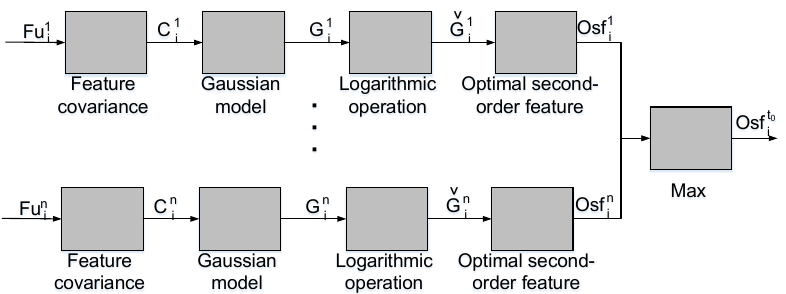
Figure 9. Maxout-Based module. This module mainly extracts the optimal second-order features and the most discriminating features of ontology essence in HRRSI, including feature covariance matrix, Gaussian model, logarithmic operation, and so